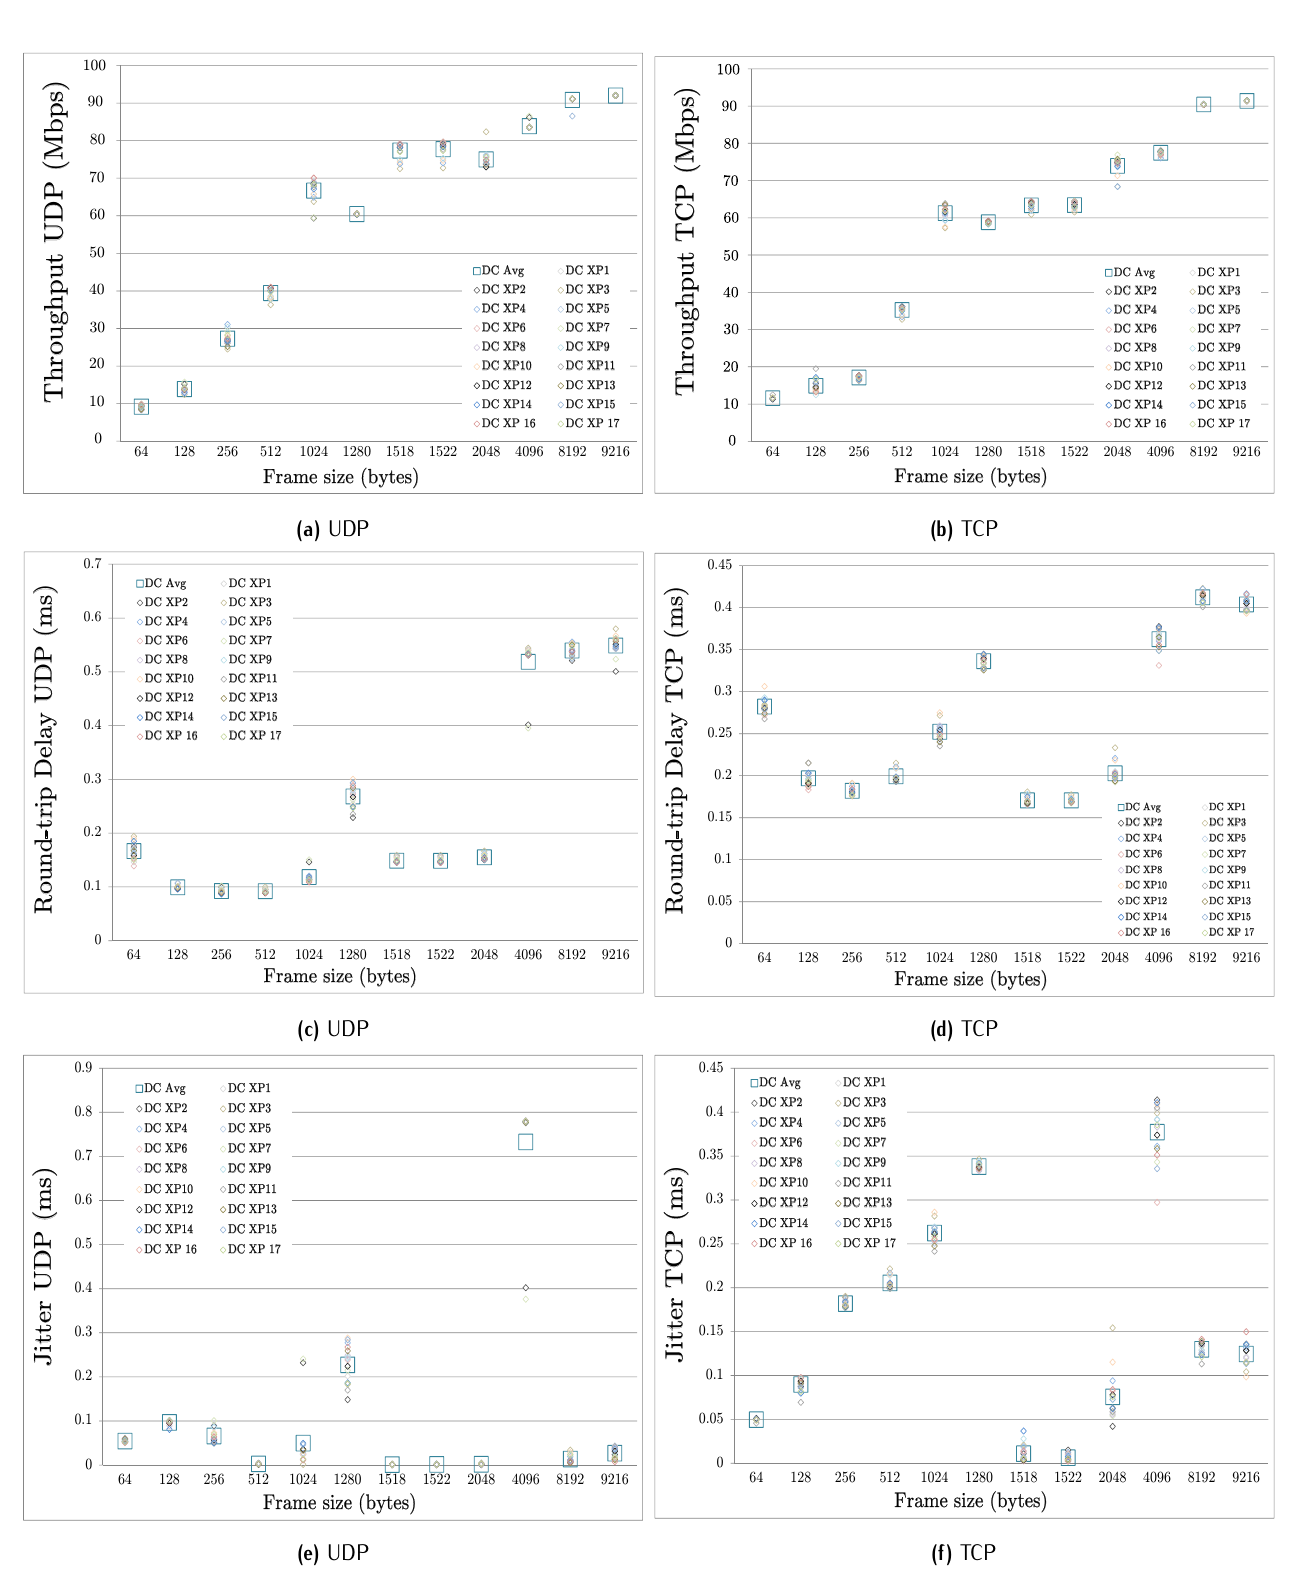
Figure 5. Repeatability of the DC